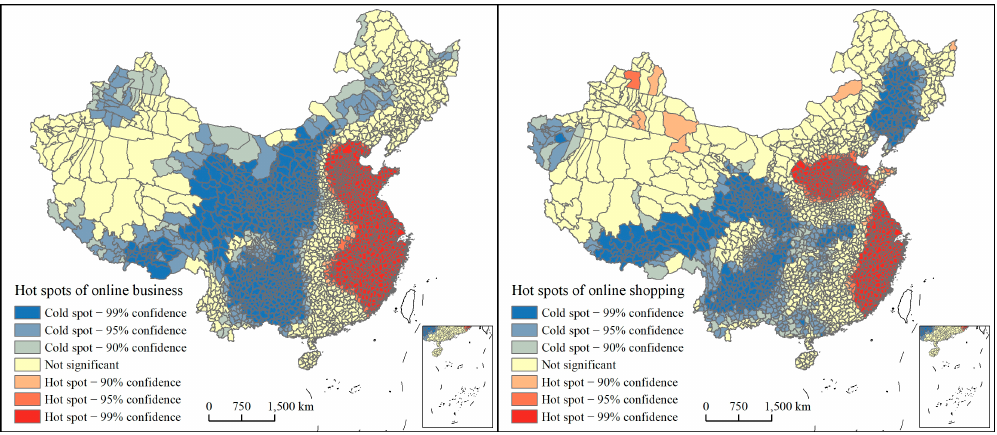
Figure 2. County-level hot spots of online business and online shopping indexes in